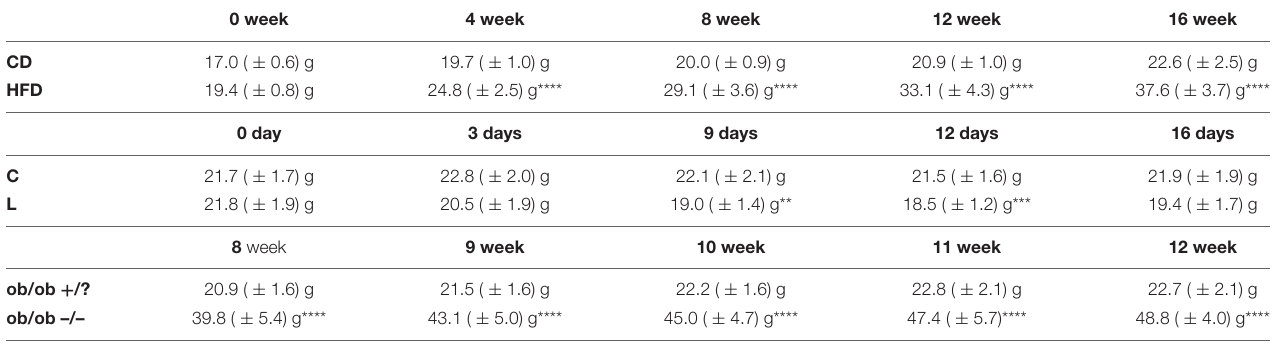
TABLE 3 | Body weight measurement of three mouse